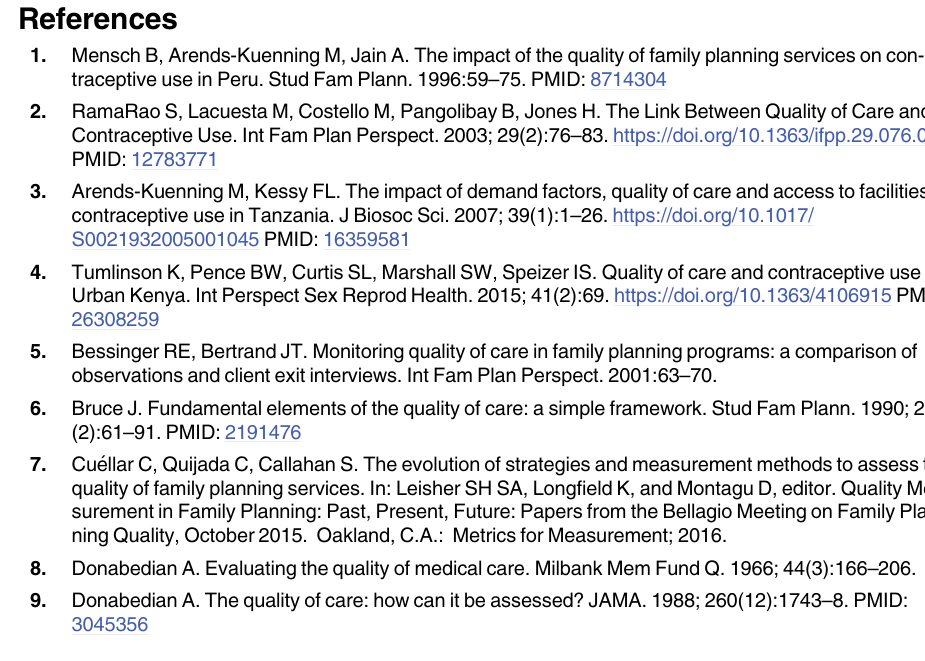
S2 Table. Availability of structure items among facilities with and without client observa- tion data. S3 Table. Percent distribution of facilities by facility background characteristic and level of quality of